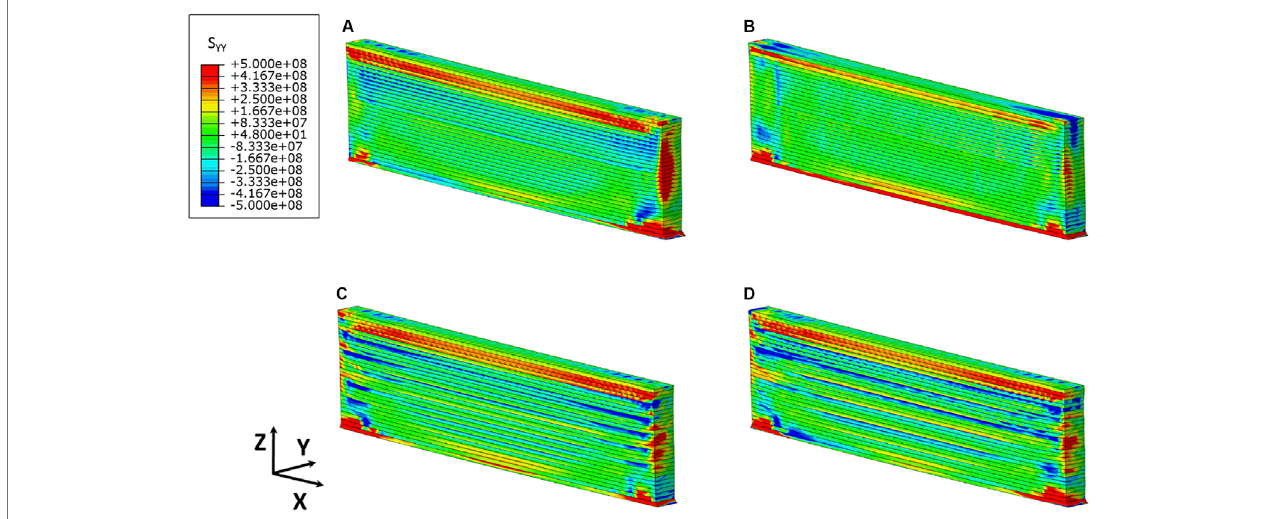
FIGURE14| Transverseresidualstress(S YY (Pa))comparisonbetweenthefourscanningpatternsdescribedin Figure1(A) Perpendicular, (B) longitudinal, (C) 90 ° rotation and (D) 45 ° rotation. The residual stresses are shown along a centerline cross section of the part-scale